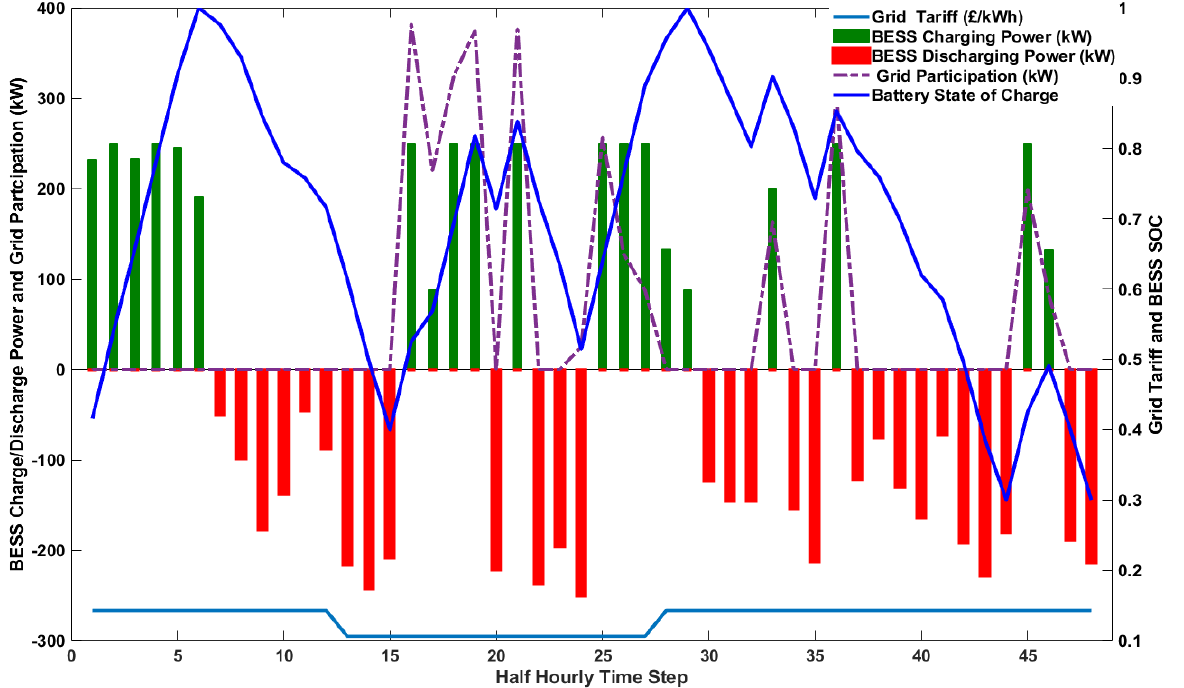
Figure 16. Total electrical power generated, real-time load demand, and BESS charge/discharge command (scenario 4).